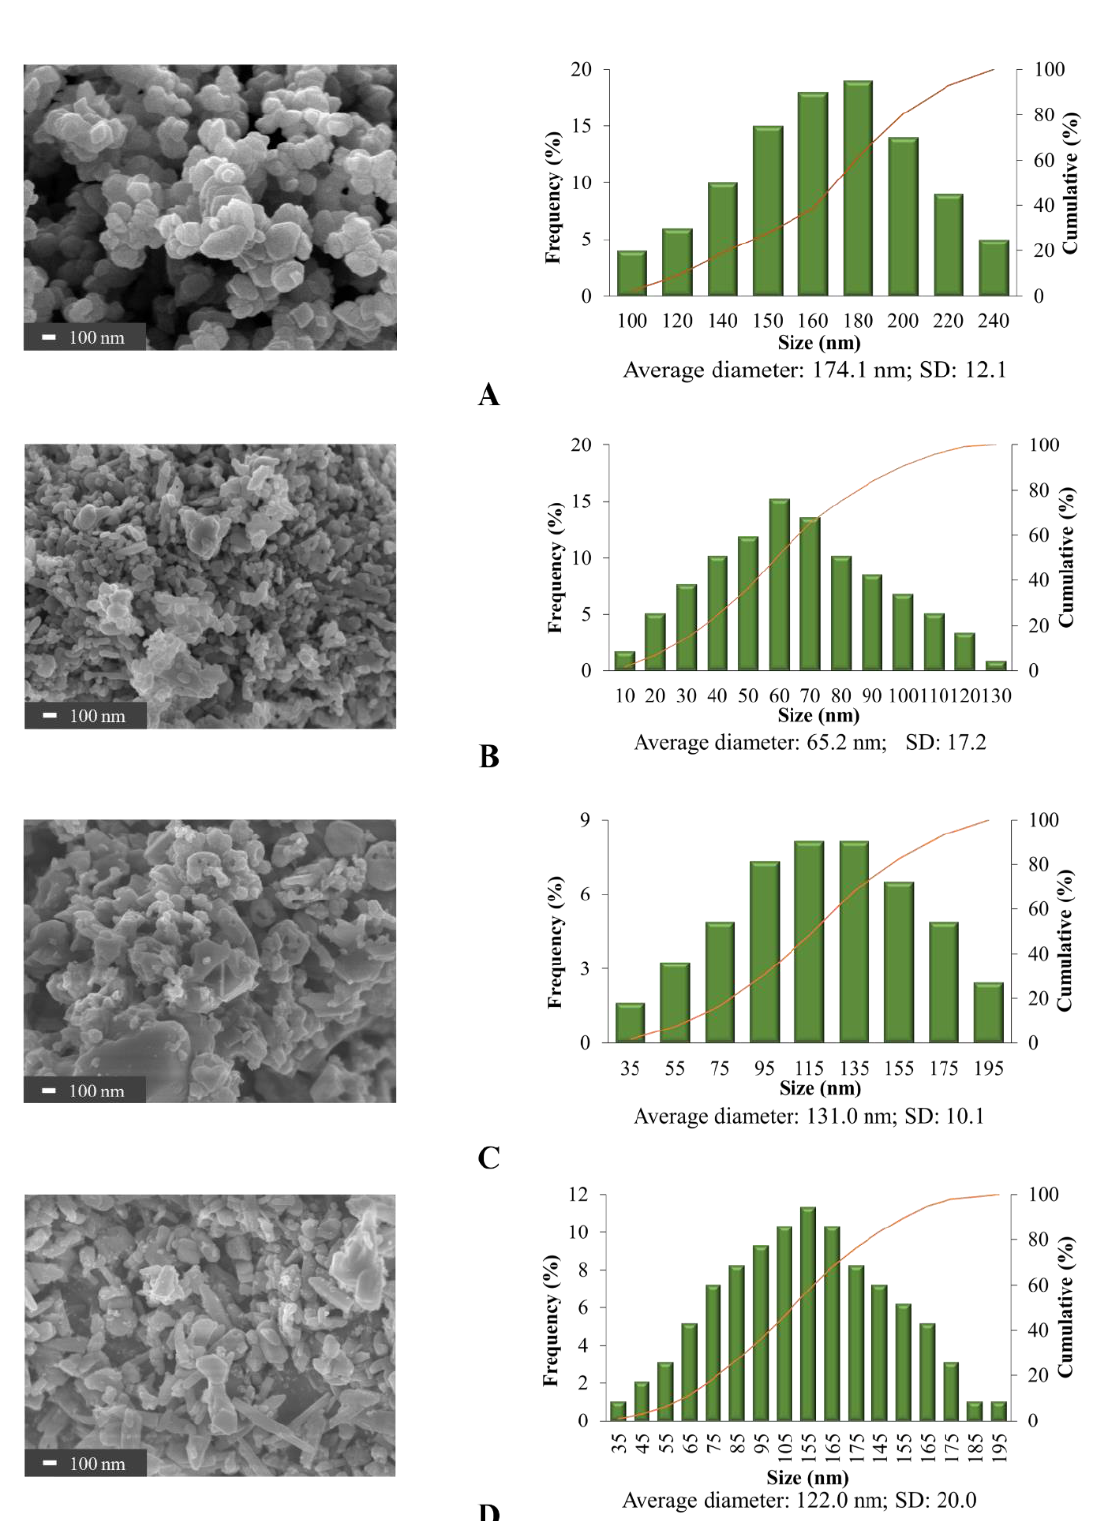
Figure 3. Morphology by field-emission-scanning-electron-microscopy (FE-SEM) imaging by secondary electron detector and size analysis of ( A ) commercial α-Fe 2 O 3 , ( B ) synthesized α-Fe 2 O 3 at 2 x CMC SDS, ( C ) synthesized α-Fe 2 O 3 at 2 x CMC CTAB and ( D ) synthesized α-Fe 2 O 3 at 2 x CMC TX100.